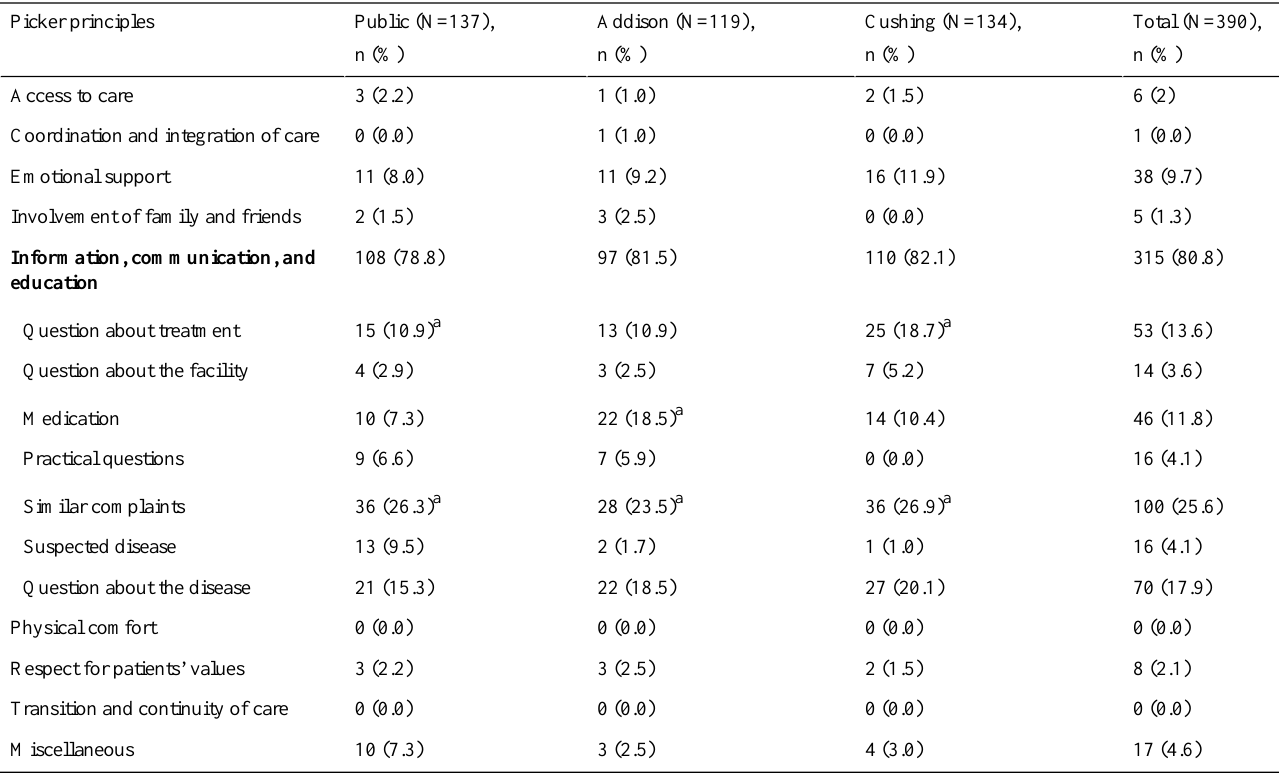
Table 1. Total amount of questions, categorized per Picker